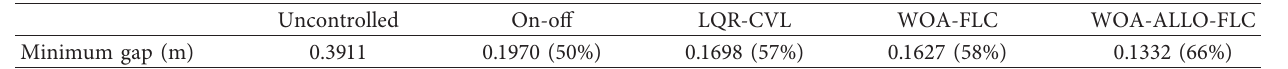
Table 10: Comparison of minimum anticollision gaps among different control